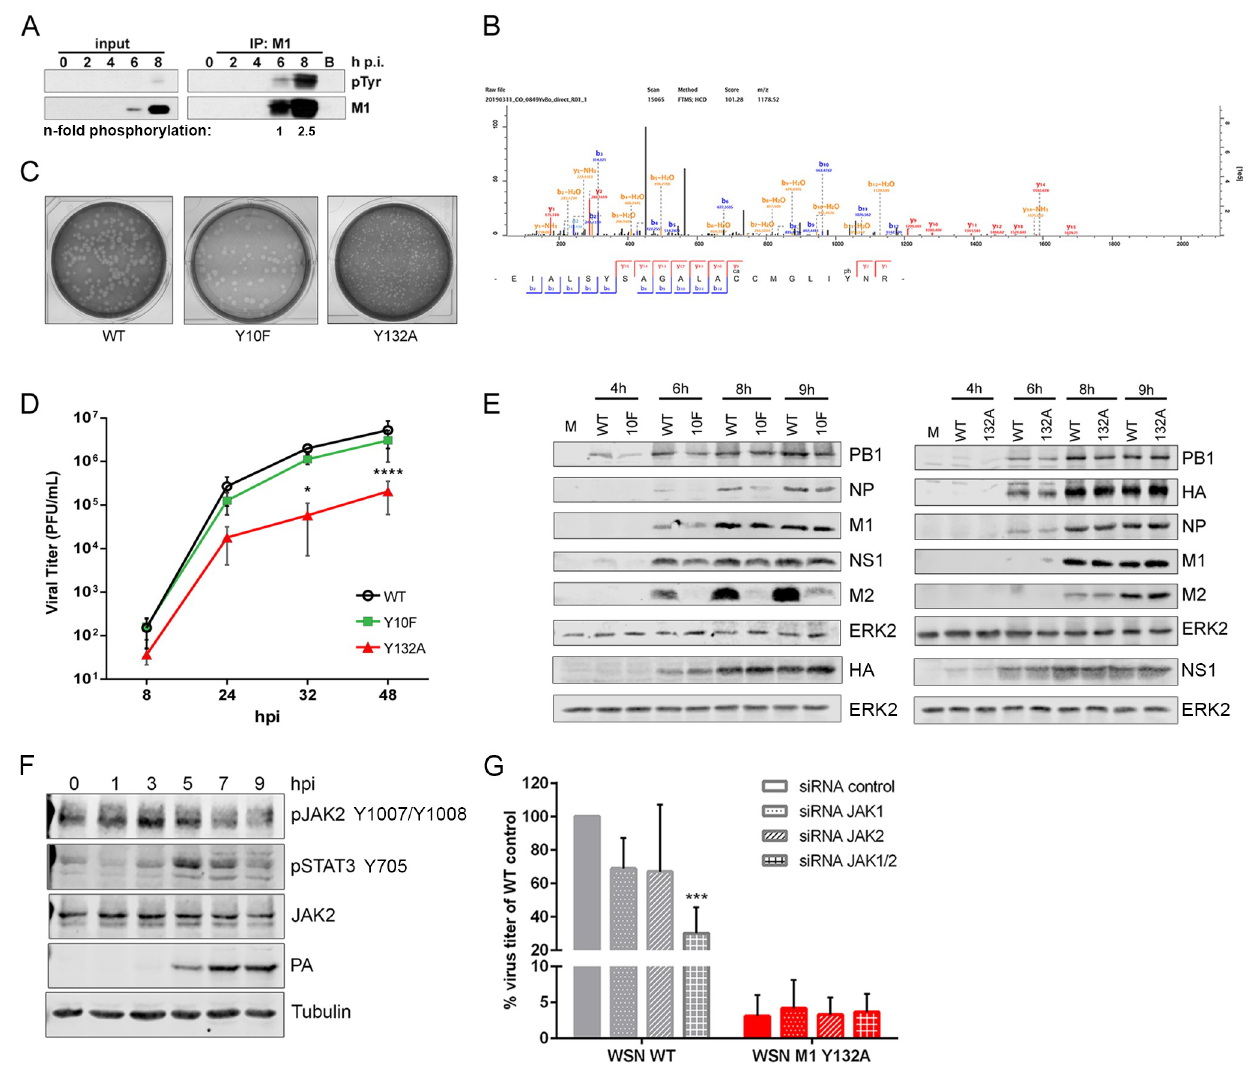
Fig 1. Phosphorylation of M1 Y132 late in the infection cycle is needed for efficient virus replication. A) M1 was immunoprecipitated with M1-specific antibodies from WSN-infected A549 cells (5 MOI; 2, 4, 6, 8 hpi) followed by analysis of M1 tyrosine phosphorylation in western blot by using pY antibodies. IP efficiency was analyzed by detection of M1. Blots are representative of two independent experiments. N-fold increase in pY M1 was analyzed by densitometric analysis of respective band intensities of pY M1 and total M1. Phosphorylation intensities were normalized to respective M1 amounts and pY detected 6 hpi was arbitrarily set to 1. B) MS/MS spectrum of the tryptic peptide EIALSYSAGALACCMGLIYNR of M1 isolated from WSN virus particles showing phosphorylation at Y132. LC-MS/MS analyses were performed on a Proxeon Easy-nLC coupled to a QExactice mass spectrometer. The MS data were processed using MaxQuant software (version 1.5.2.8. with integrated Andromeda search engine). C) Plaque phenotypes of WSN WT (left), M1 Y10F (middle) and M1 Y132A (right). Dilutions from standard plaque assays were stained with neutral red. D) A549 cells were infected with 0.01 MOI WSN WT, M1 Y10F or M1 Y132A. Virus-containing supernatants were harvested 8, 24, 32 and 48 hpi. Titers were determined by standard plaque assays and are depicted as mean ( ± SD) of three independent experiments. Statistical significance was analyzed by two-way Anova followed by Dunett’s multiple comparison test ( � p � 0.05, ���� p � 0.0001). E) A549 cells were infected with 1 MOI WSN WT, M1 Y10F or M1 Y132A and expression of viral proteins PB1, NP, HA, M1, NS1 and M2 was analyzed 4, 6, 8 and 9 hpi. ERK2 expression served as loading control. Blots are representative of three independent experiments. F) A549 cells were infected with 5 MOI WSN WT and activation of JAK2 and STAT3 was analyzed by detection of phosphorylation of Y1007/ Y1008 (JAK2) and Y705 (STAT3), respectively. Expression of viral PA was analyzed to confirm efficient infection. JAK2 and tubulin expression served as loading controls. Blots are representative of three independent experiments. G) A549 cells were transfected with JAK1-, JAK2- or a combination of specific siRNAs for 48 h and were subsequently infected with 0.1 MOI WSN WT or M1 Y132A. Virus-containing supernatants were harvested 8 hpi and viral titers were determined by standard plaque assays and are depicted as mean ( ± SD) of three independent experiments. Statistical significance was analyzed by two- way Anova followed by Dunett’s multiple comparisons test ( ��� p �